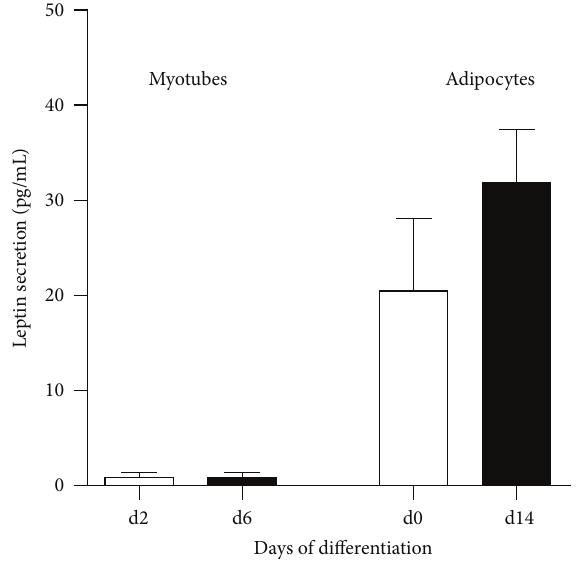
Figure 2: Leptin secretion from primary human myotubes and adipocytes. Primary human skeletal muscle cells and preadipocytes were differentiated in vitro for 6 and 14 days, respectively. Super- natants were collected on day 2/6 and day 0/14 of differentia- tion, respectively. Leptin secretion was measured by ELISA (R&D Systems), 𝑛 ≥ 8 . Samples were measured according to the manufacturer’s